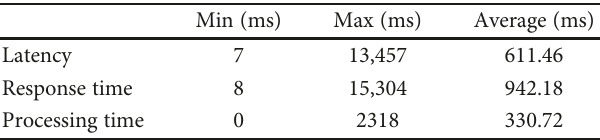
Table 8: Test result of the emulation mode with time (performance measurements).